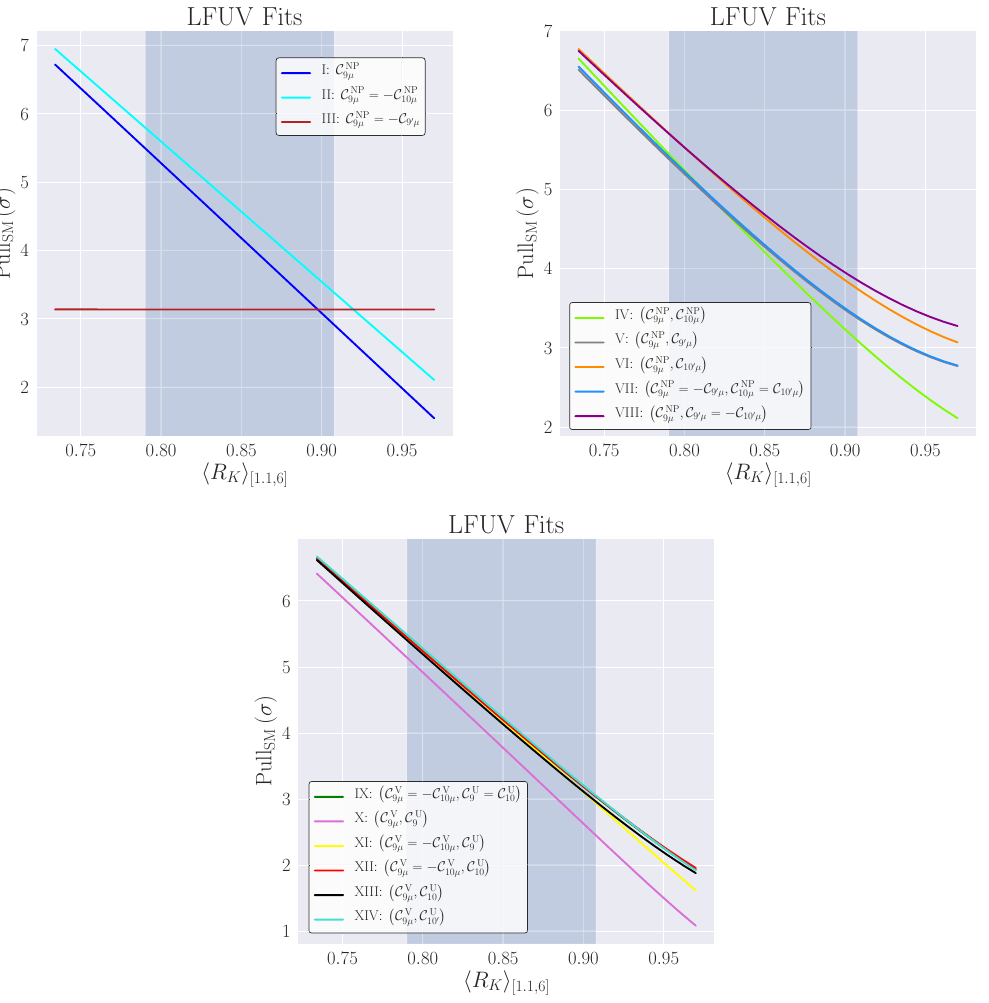
Figure 7. LFUV fit: impact of the central value of under